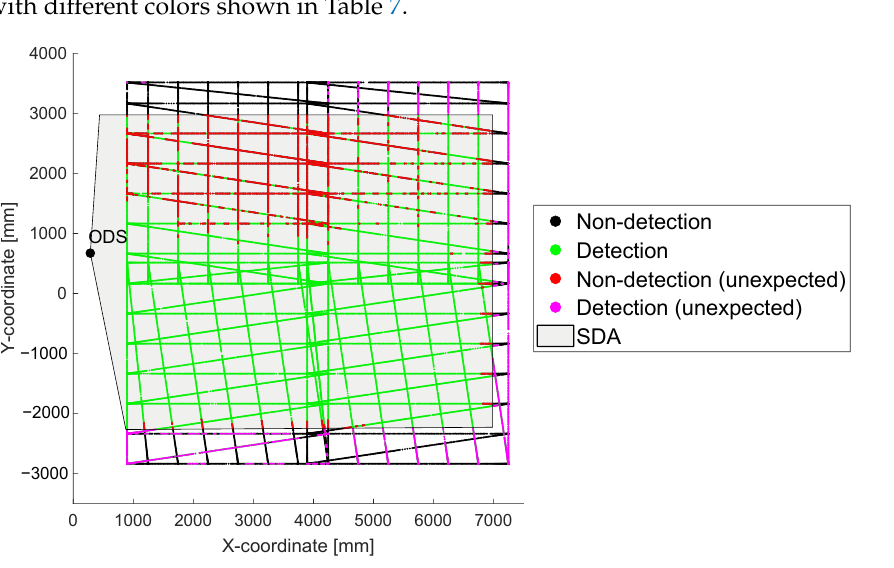
Figure 10. In this graph the point cloud from Figure 5 is shown with the new evaluated four variants of